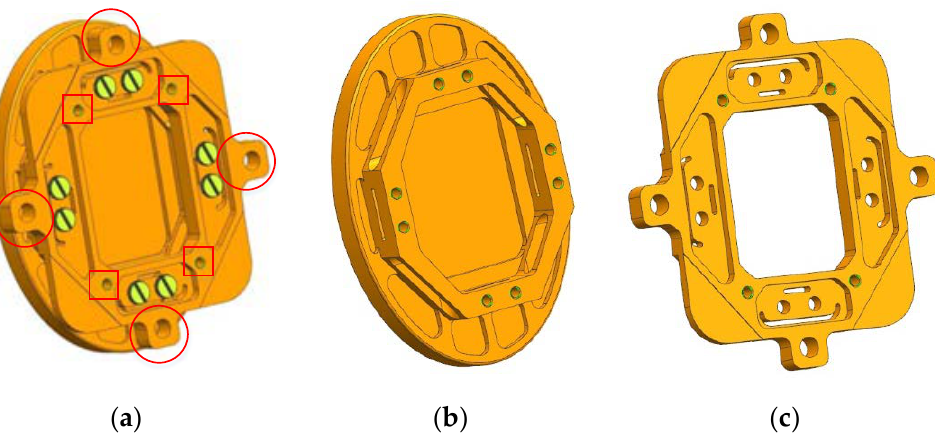
Figure 7. Outline of mirror: ( a ) Assembly; ( b ) Mirror body; ( c ) Backplane. The physical objects of the visible light mirror and infrared mirror are shown in Figure 8. The infrared mirror surface is plated with gold reflection film, and the visible light mirror is plated with aluminum reflection film. The results of the surface profile accuracy tested by the Zygo interferometer are shown in Figure 9 (the assembly of the FSM was completed before the test). The RMS of the visible light mirror is 15.8 nm and that of the infrared mirror is 41.1 nm. The surface profile accuracy meets the design requirements.